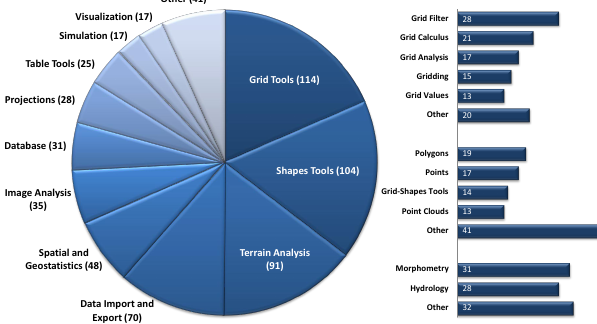
Visualization (17) Simulation (17) Table Tools (25)